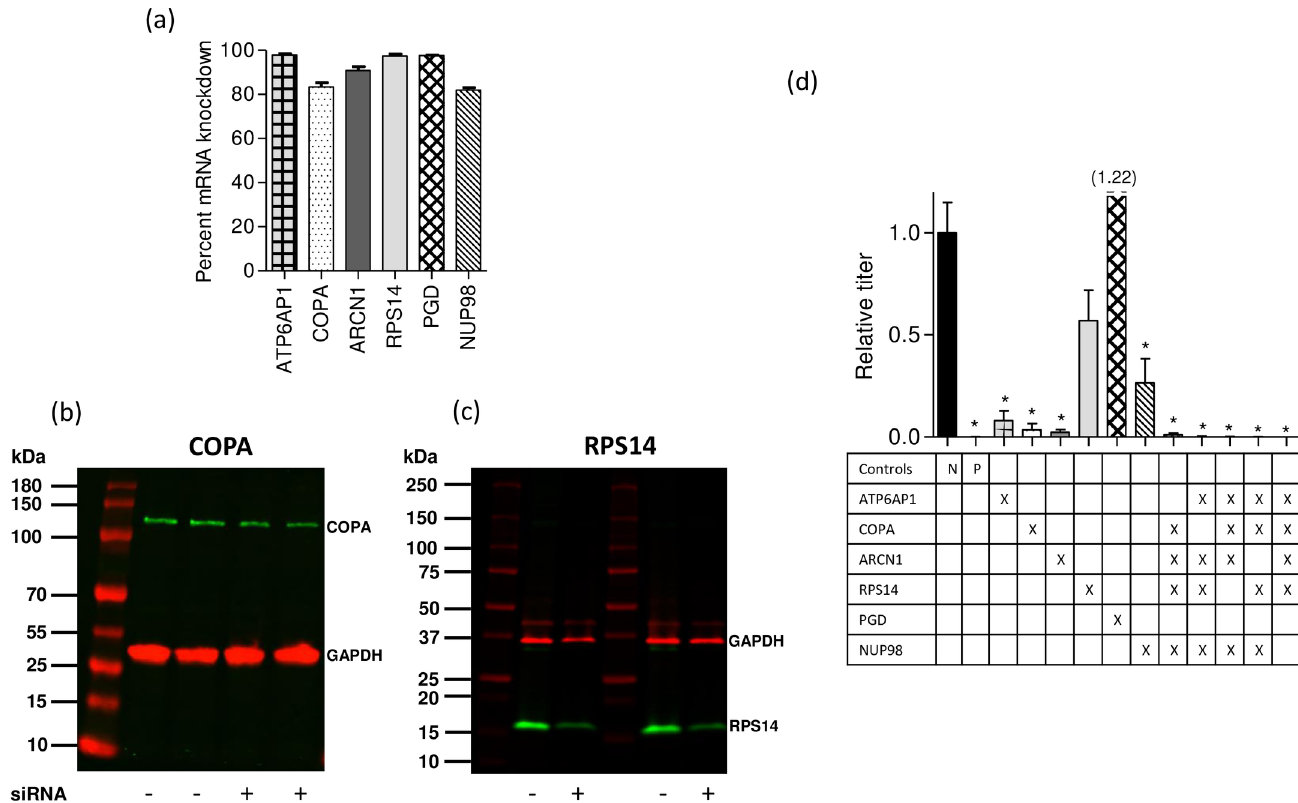
Fig 2. siRNA knockdown of mRNA and protein expression of targeted genes in A549 cells and the impact on influenza A/WSN/1933 (WSN) replication. (a) Knockdown efficiency of mRNA in A549 cells. Bars represent mean (+ SEM) knockdown relative to non-targeting siRNA 24 hours post transfection. (b) and (c) Knockdown efficiency of protein in A549 cells. Lysates from siRNA- and mock-transfected A549 cells were quantified using the BCA protein assay, then 10 μ g (COPA, predicted size of 140 kDa) or 5 μ g (RPS14, predicted size of 17 kDa) were analyzed by SDS-PAGE as 2 biological replicates. The protein band intensities of COPA and RPS14 (green) were normalized to the levels of GAPDH (red). (d) Inhibition of viral replication when genes were targeted singly, or in combination. For each bar, the targeted genes are shown (X) below. The Allstars negative control (N) and siNP positive control (P) are shown. Results are displayed as normalized to viral growth in cells transfected with non-targeting siRNA. ( (cid:3) p < 0.05, (cid:3)(cid:3) p < 0.01). A549 cells were transfected with siRNA 24 hours after plating. Cells were infected with WSN virus (MOI = 0.12) 24 hours following siRNA transfection and incubated for 48 hours prior to evaluating viral titer by plaque assay.